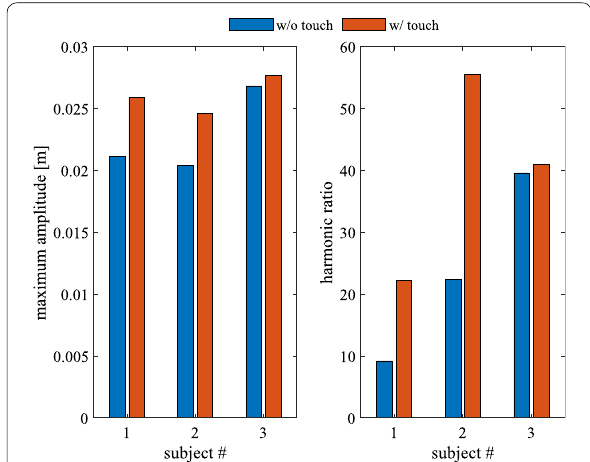
Fig. 12 Maximum amplitude and harmonic ratios of the sacrum positions of each subject in x-axis. The left figure shows the maximum amplitudes of the subjects’ sacrum at the frequencies of the trials, and the right one shows their harmonic ratio in x-axis (lateral direction). The maximum amplitudes of no subject decreased. On the other hand, the harmonic ratios of all subjects increased